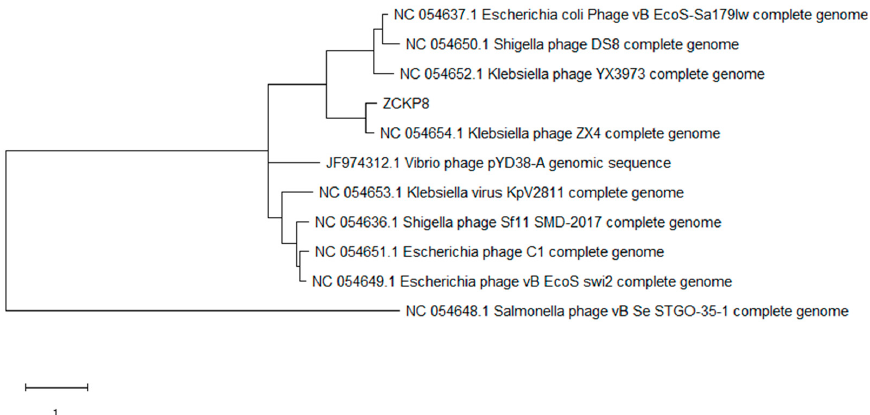
Figure 1. Transmission electron microscopic image of phage ZCKP8.